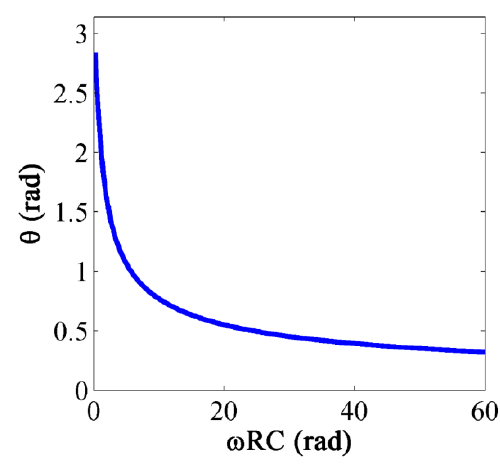
Figure 8. The flow angle ( θ ) versus ω